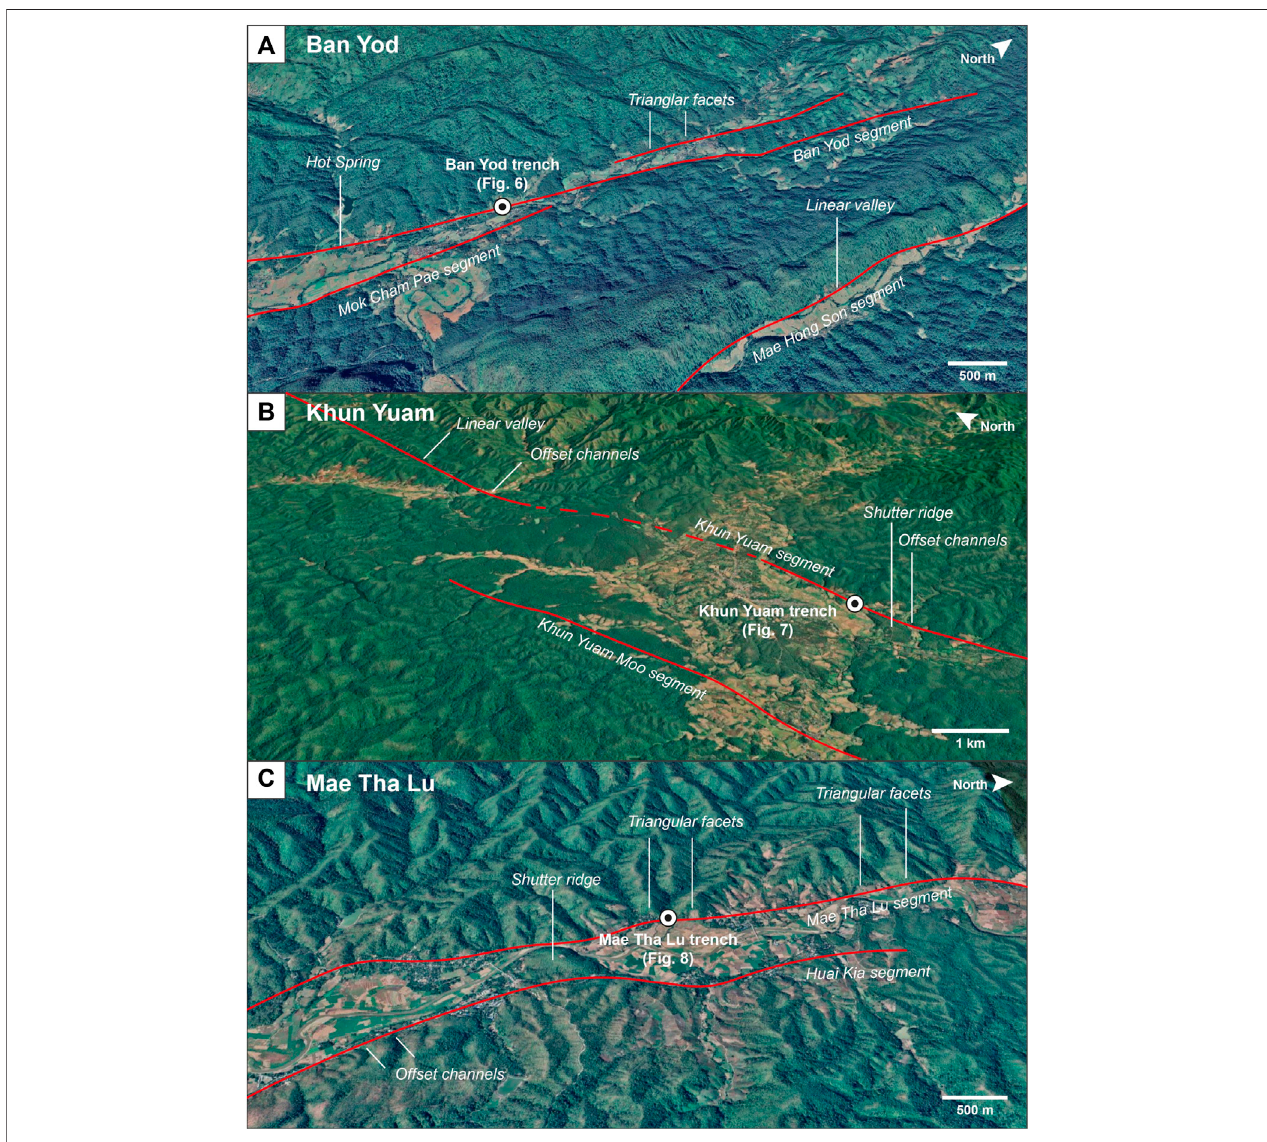
FIGURE5| GoogleEarthimagesshowthelocationofthefaulttrenchesanddetailedtectonicgeomorphicevidenceat (A) theBanYod, (B) KhunYuam (B) ,and (C) Mae Tha Lu.